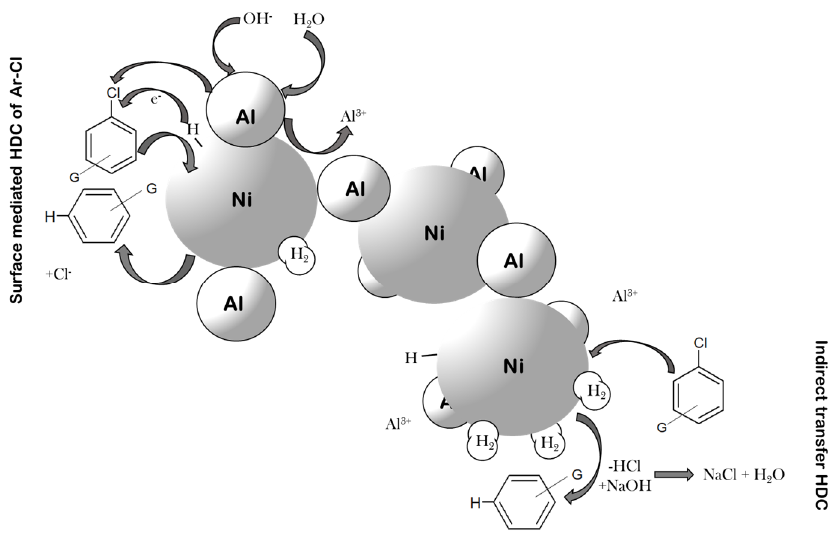
Figure 13. Scheme of HDC mechanisms using the Raney Al-Ni Figure 13 . Scheme of HDC mechanisms using the Raney Al-Ni alloy.